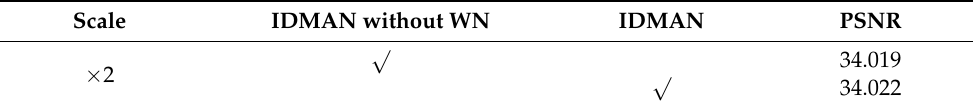
Table 4. The effectiveness of WN on the model. We compared the result of network without WN after 2 × 10 5 iterations on the validation set for × 2 scale SR. Scale IDMAN without WN × 2